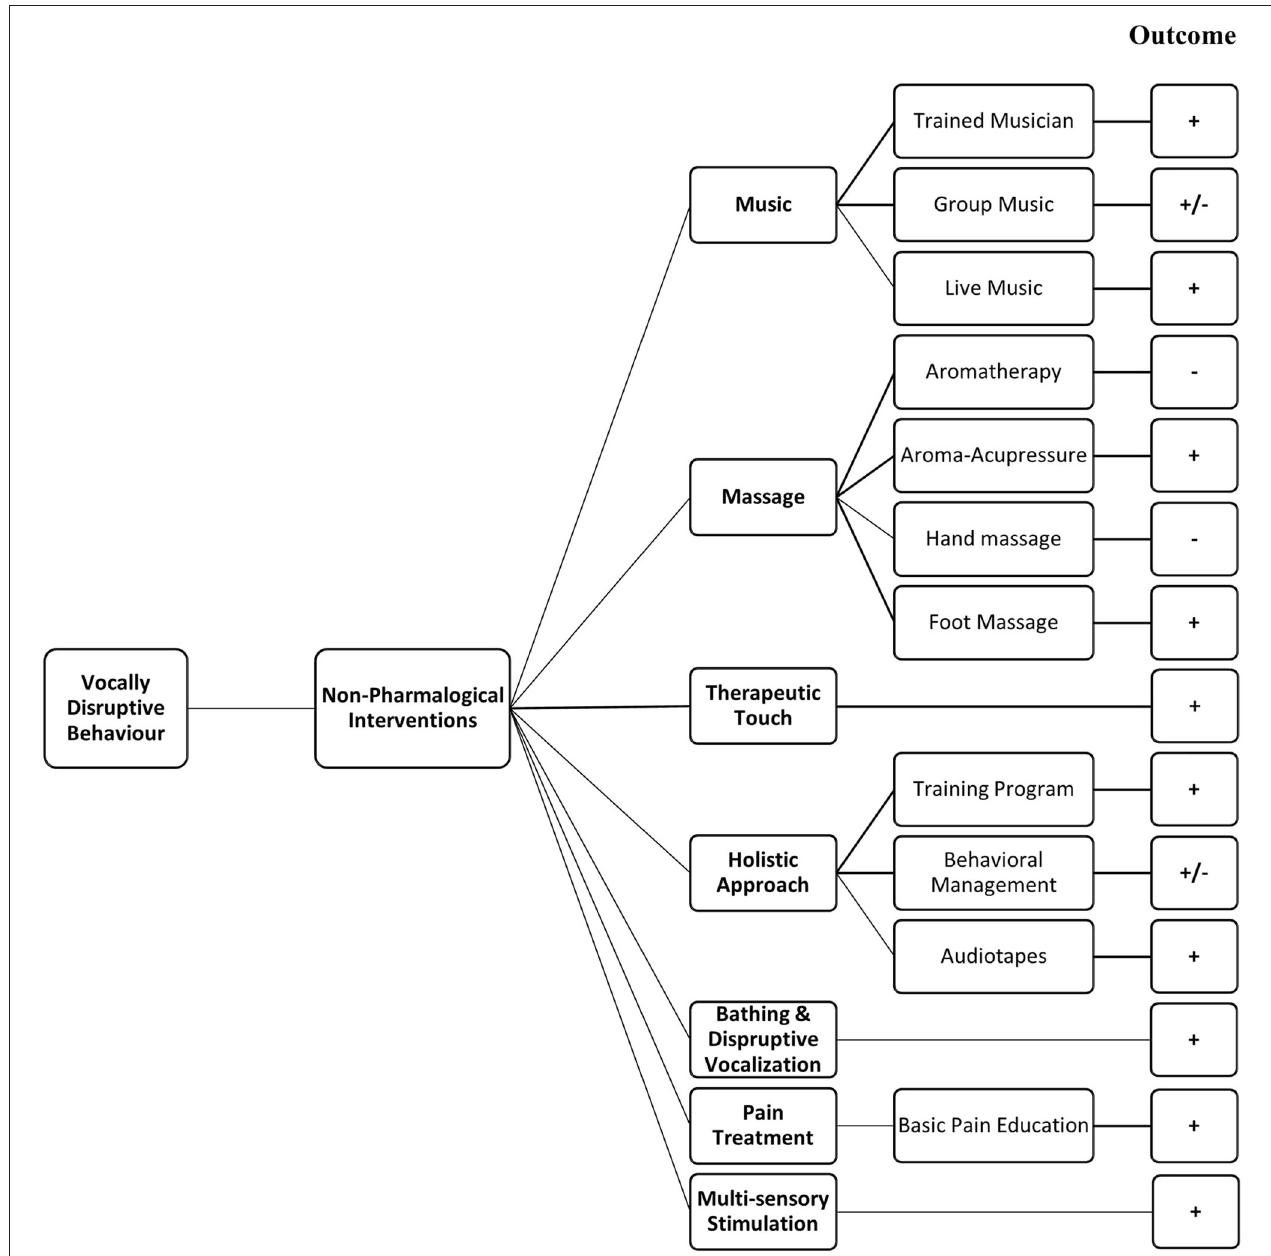
FIGURE 2 | Summarised effects of non-pharmacological interventions.